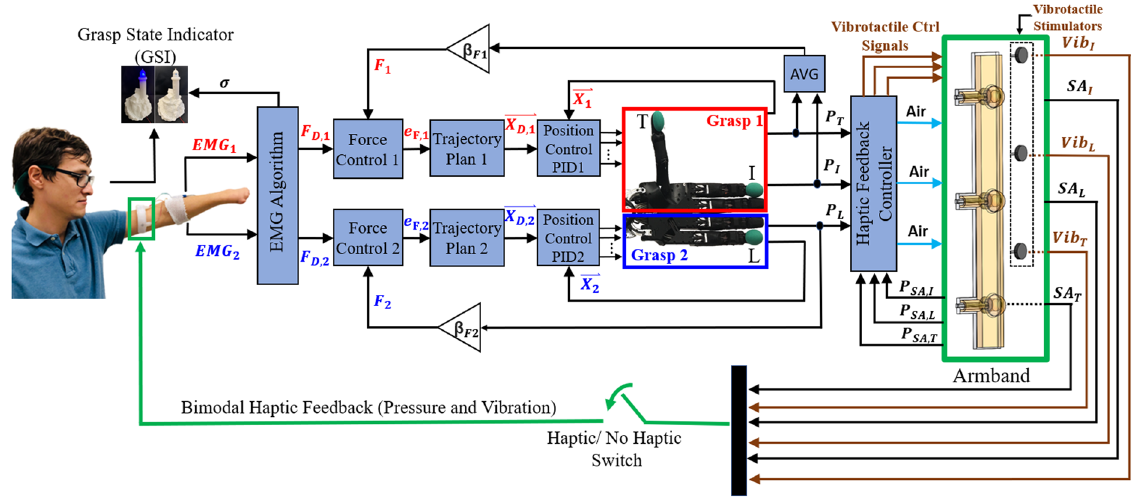
Figure 6. Control system overview. Hybrid force–velocity controllers to simultaneously control the forces applied to two different objects grasped by a dexterous Shadow Hand. The haptic feedback controllers (right) provided bimodal multichannel tactile information from three of the robotic fingertips, using the soft actuators and fast-acting vibrotactile information, used here to signal breakage of one or both